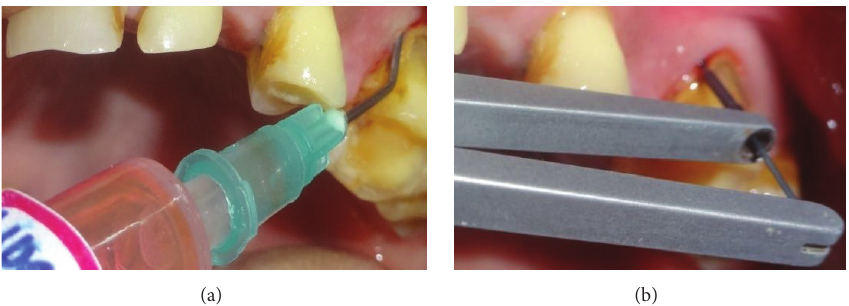
Figure 5: (a) Administration of 10% lidocaine gel. (b) Administration of 10% lidocaine gel followed by Florida probing.